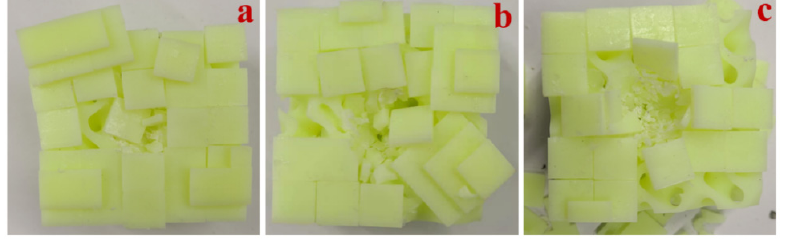
Figure 5. Experimental results. ( a ) B-C-A composite structure. ( b ) B-C-B composite structure. ( c ) B-C-C composite structure.